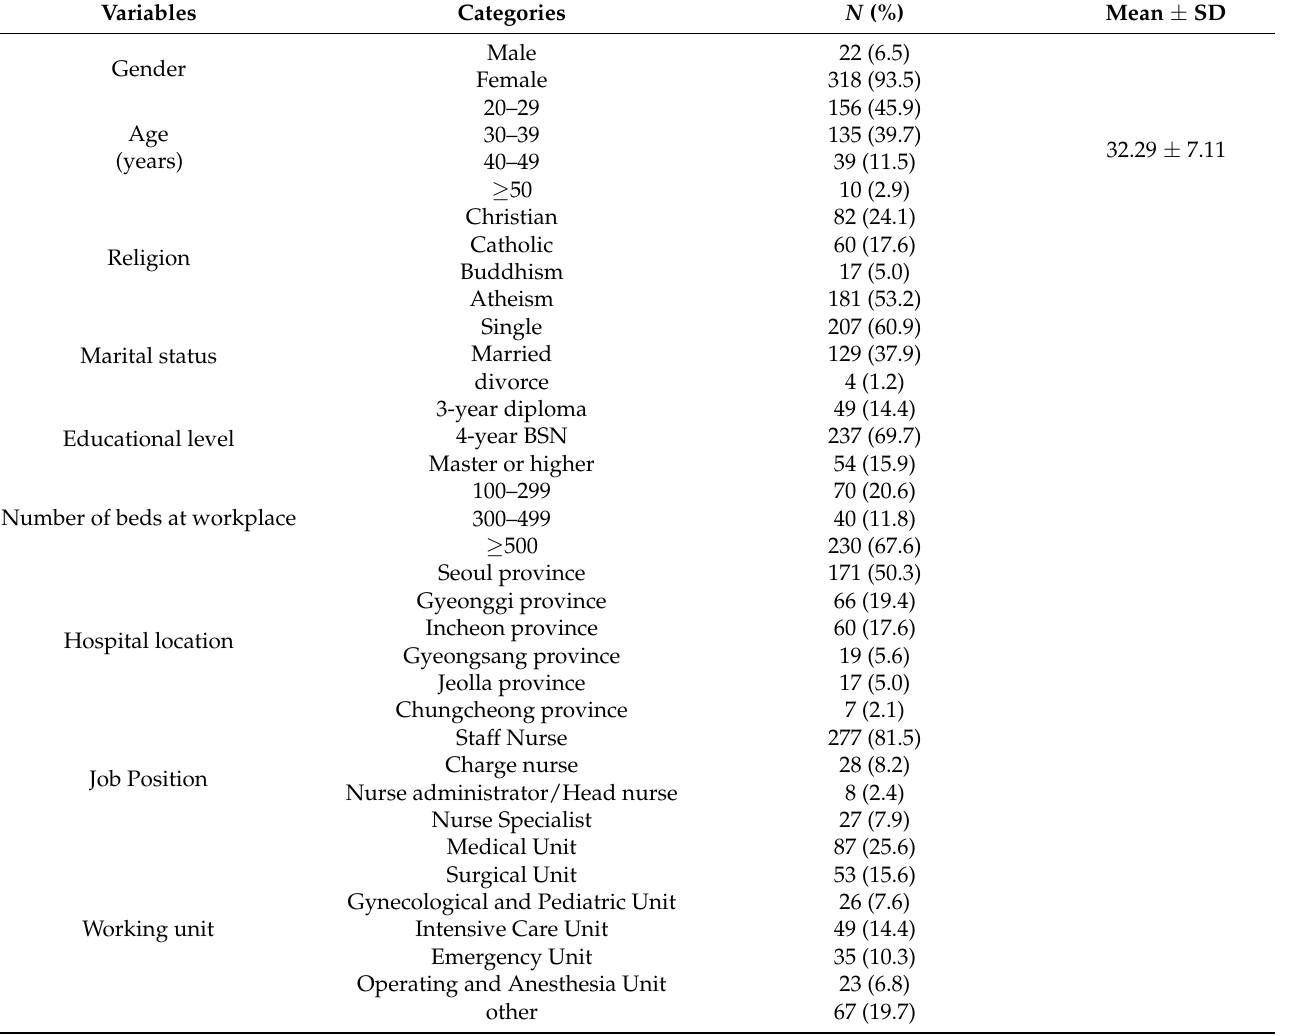
Table 1. General Characteristics of the Subject ( N =